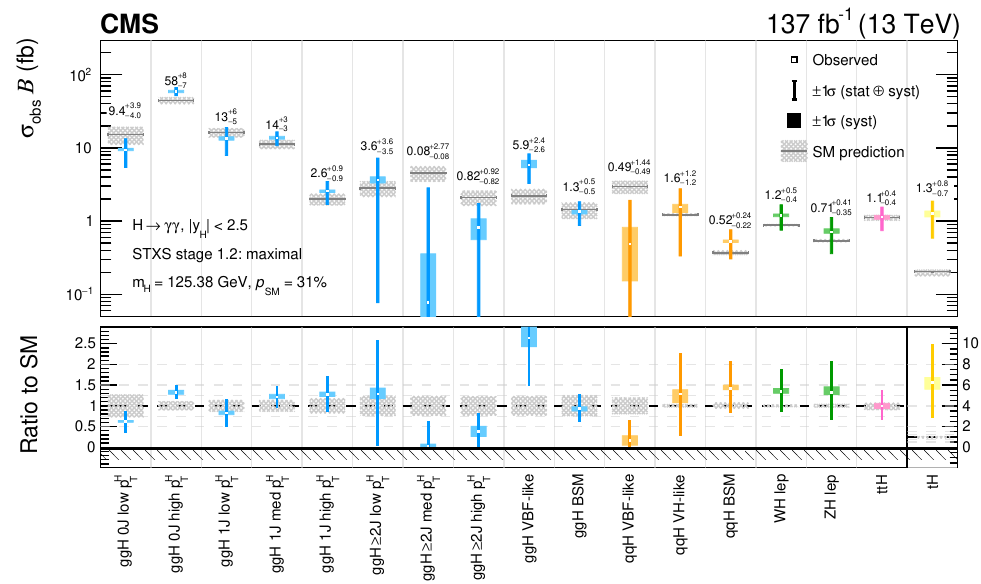
Figure 18 . Observed results of the maximal merging scheme STXS fit. The best fit cross sec- tions are plotted together with the respective 68% CL intervals. The systematic components of the uncertainty in each parameter are shown by the coloured boxes. The hatched grey boxes demon- strate the theoretical uncertainties in the SM predictions. The lower panel shows the ratio of the fitted values to the SM predictions. Here the tH cross section ratio has a different scale, due to its high best fit value and uncertainty. The cross sections are constrained to be non-negative, as indicated by the hashed pattern below zero. The parameters whose best fit values are at zero are known to have 68% CL intervals which slightly under-cover; this is checked to be a small effect using pseudo-experiments. The colour scheme is chosen to match the diagram presented in figure 1. The compatibility of this fit with respect to the SM prediction, expressed as a p -value, is approxi- mately